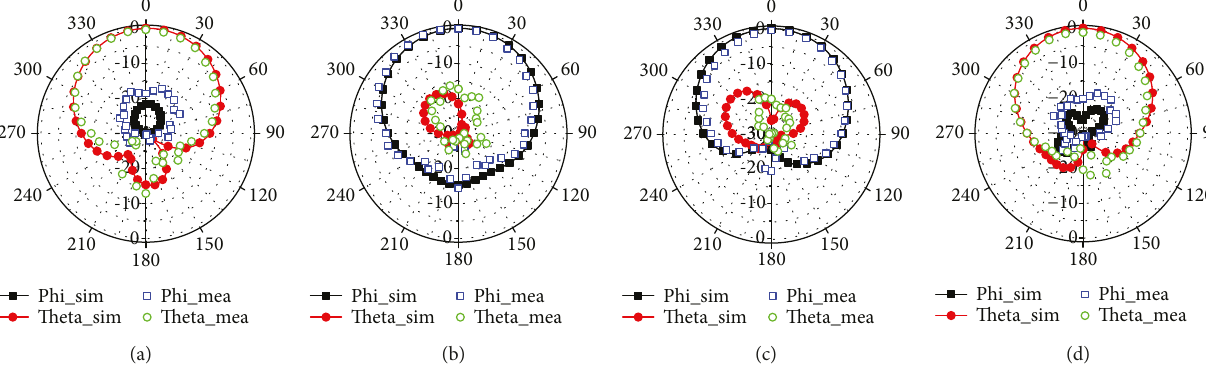
Figure 8: Measured radiation patterns of antenna 2: (a) yz -plane at f